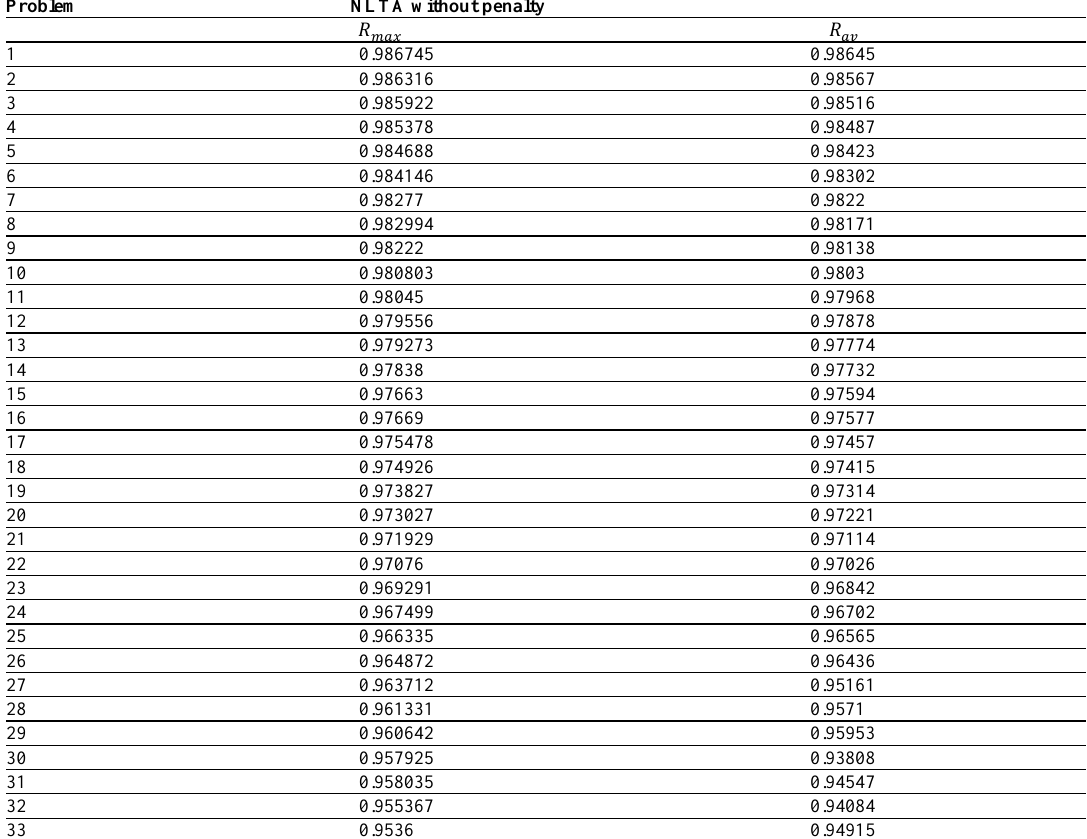
Table 5. Results of the NLTA without penalty: case of binary-state systems.